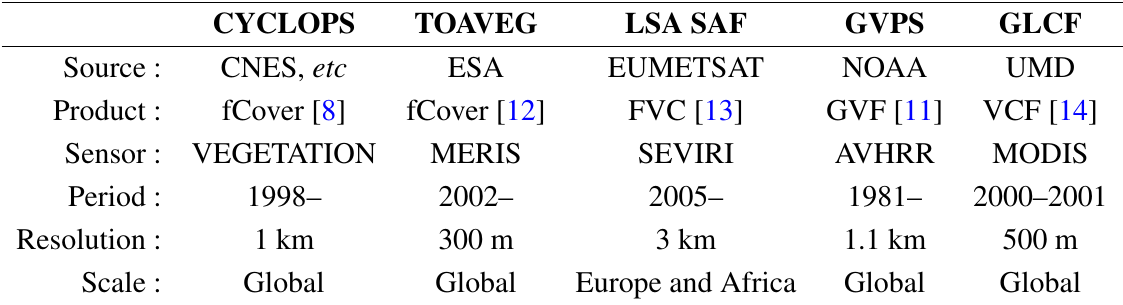
Table 1. Summary of the major FVC-equivalent